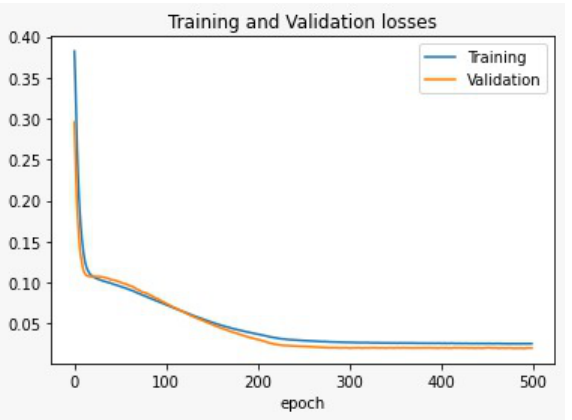
Figure 8. The training and validation losses for the single hidden layer deep learning (MLP).